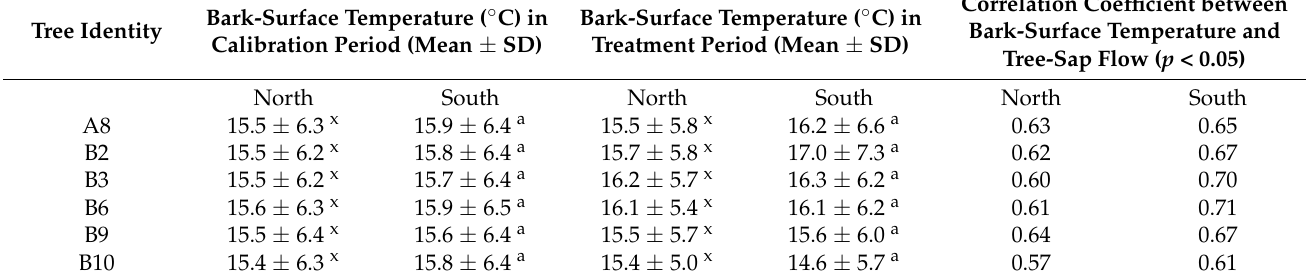
Table 3. Bark-surface temperatures of the sample trees before and after forest-edge cutting and the correlation between bark-surface temperatures and tree-sap flow. Superscript letters in the same line indicate significant differences ( p < 0.05) between the same aspects for 2019 and